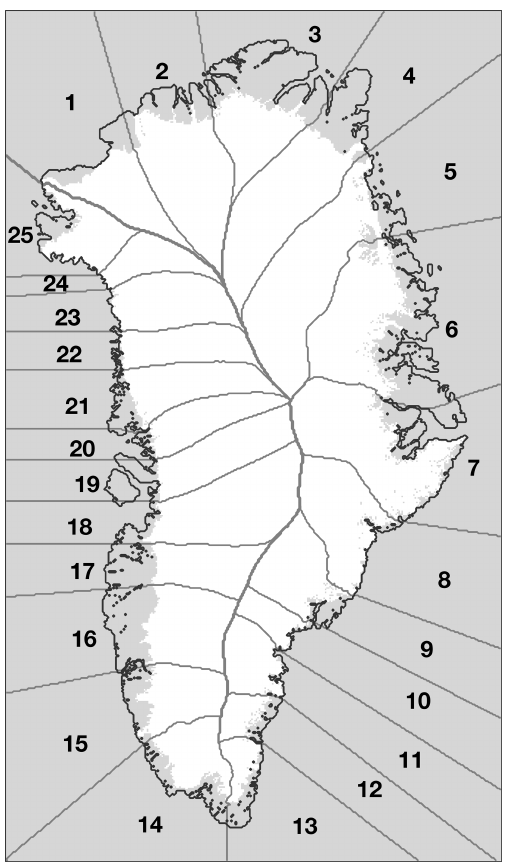
Figure 2. Basin separation. The basin delineation is based on Mouginot et al. (2019), combined into a set of 25 regional basins and extended to the grid